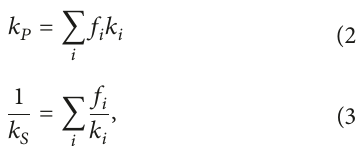
and indirect coupled-analysis model. In the indirect coupled- analysis model, time is divided into n substeps. First, starting from the initial value, with calculation of the current and magnetic field after the first substep, heat losses are achieved from hysteresis and eddy current effects. The results are transmitted to the temperature field of thermal analysis for calculating the temperature distribution. Then, the calcula- tion of the next substep is followed. For the direct coupled- analysis model, all the variables (i.e., magnetic field, heat rate, temperature, etc.) must be simultaneously